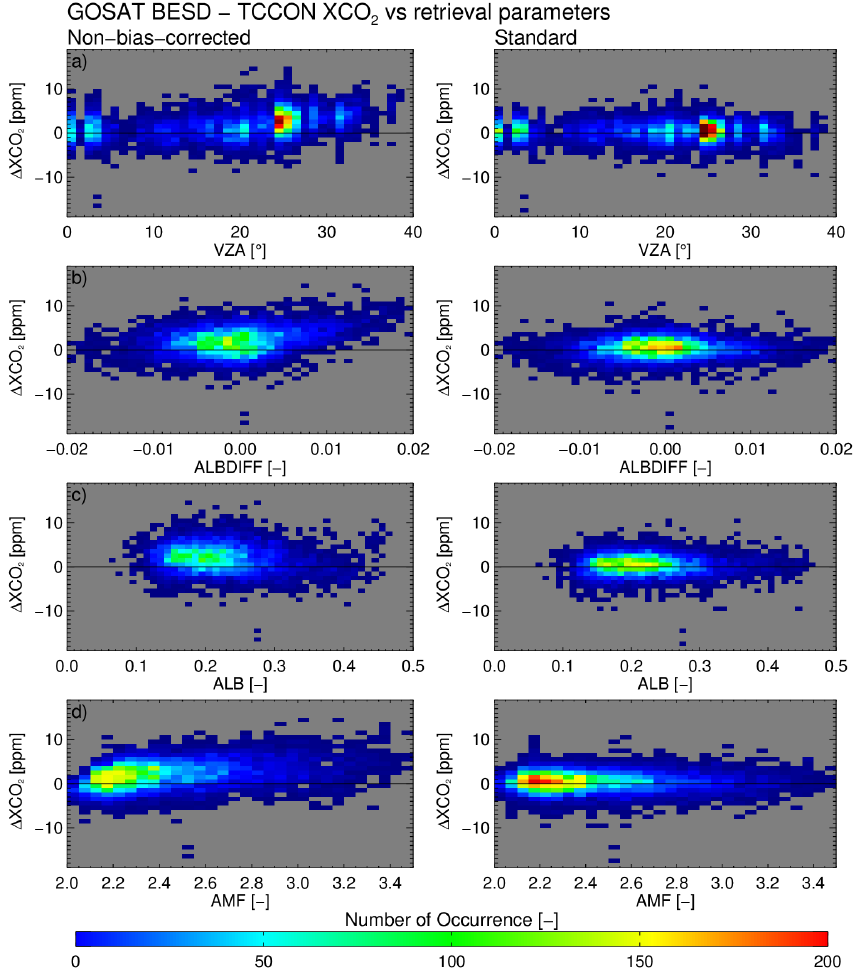
Figure 2. Two-dimensional histograms of non-bias-corrected (left) and standard (bias-corrected, right) GOSAT BESD–TCCON XCO 2 differences versus the following four retrieval parameters: (a) viewing zenith angle (VZA), (b) difference of retrieved to a priori albedo P 0 of band 2 (ALBDIFF), (c) retrieved P 0 of band 1 (ALB) and (d) air-mass factor